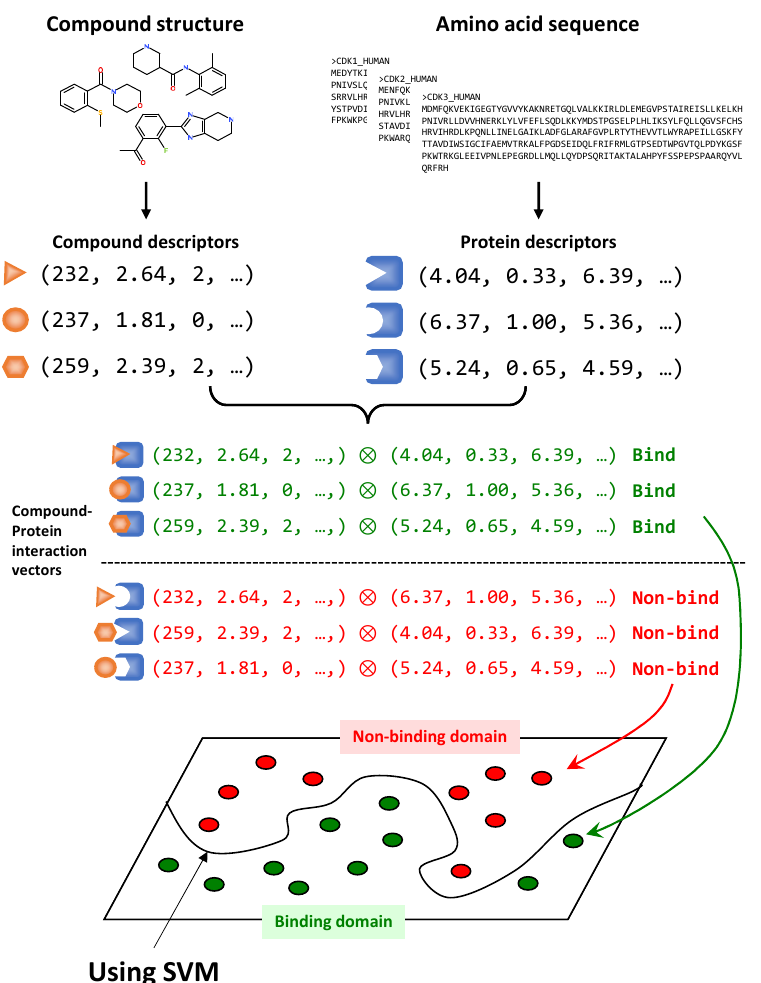
Figure 1. Schematic diagram of how CGBVS is calculated. The feature vector for a compound is obtained by calculating descriptors from the compound’s structural formula. Feature vectors for proteins are calculated from amino acid sequences. The CPI vector is created by taking the tensor product of the compound vector and the protein vector, and is labeled as binding or non-binding vectors based on the activity data in ChEMBL database. The CGBVS model is generated by machine learning of CPI vectors via